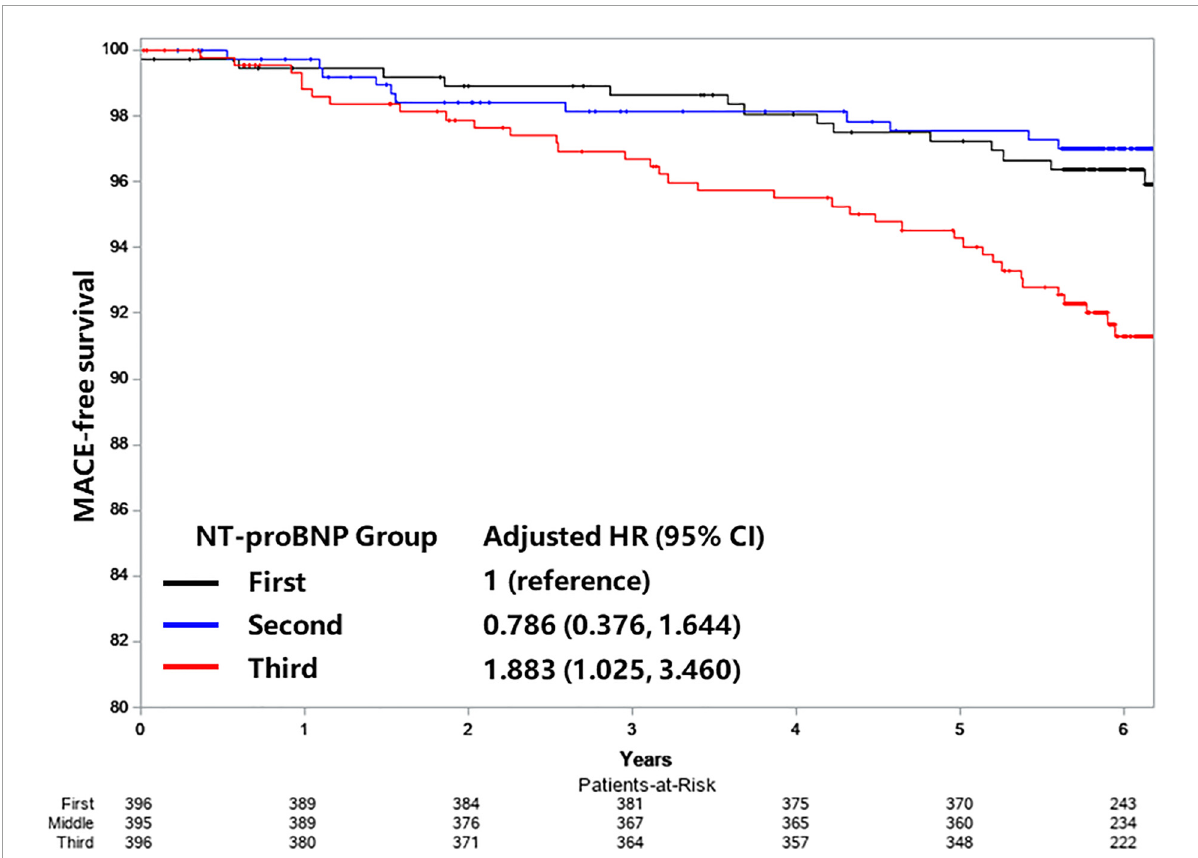
FIGURE3 Kaplan–Meier curves of MACE-free survival according to NT-proBNP tertiles. Adjusted for age, sex, body mass index (BMI), smoking status, prior history of diabetes, hypertension, left ventricular ejection fraction (LVEF), the plasma level of high-sensitivity C-reactive protein (hsCRP), endothelin, Hemoglobin A1C (HbA1C), and Free triiodothyronine